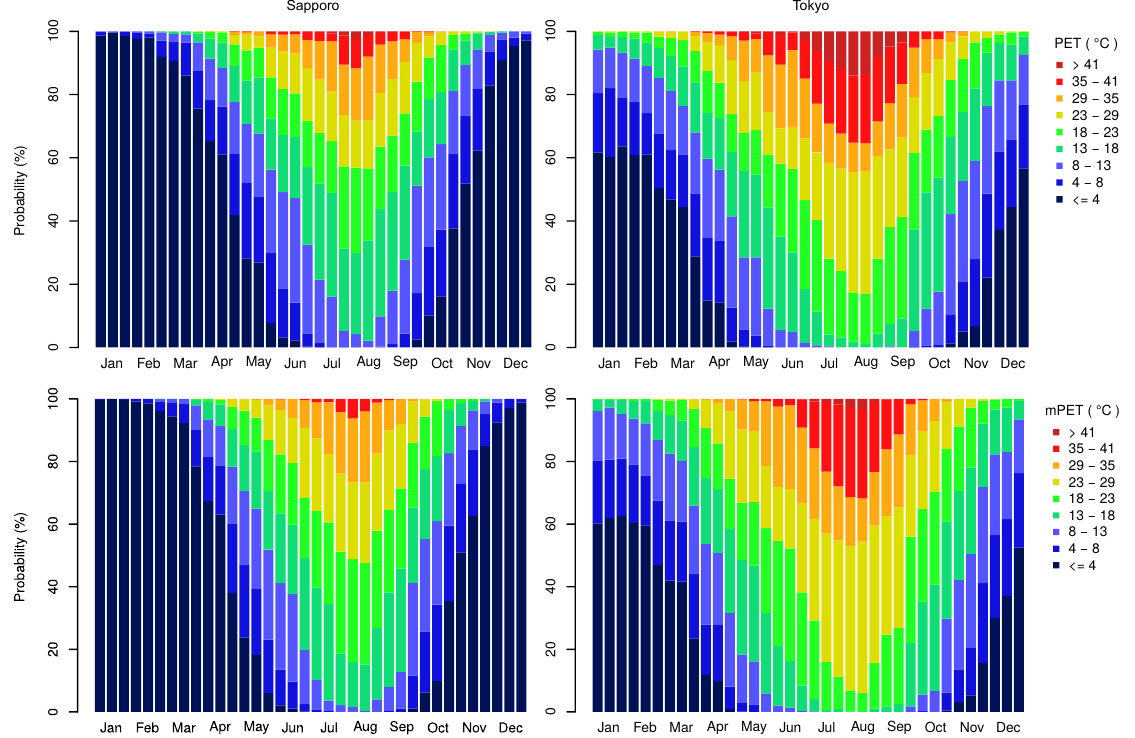
Figure 2. Frequency diagrams in an approximate decadal resolution exhibiting the average PET classes (Table 1) for Sapporo ( top left ) and for Tokyo ( top right ) and the average modified Physiologically Equivalent Temperature (mPET) classes for Sapporo ( bottom left ) and for Tokyo ( bottom right ) covering the period from October 1966 to June